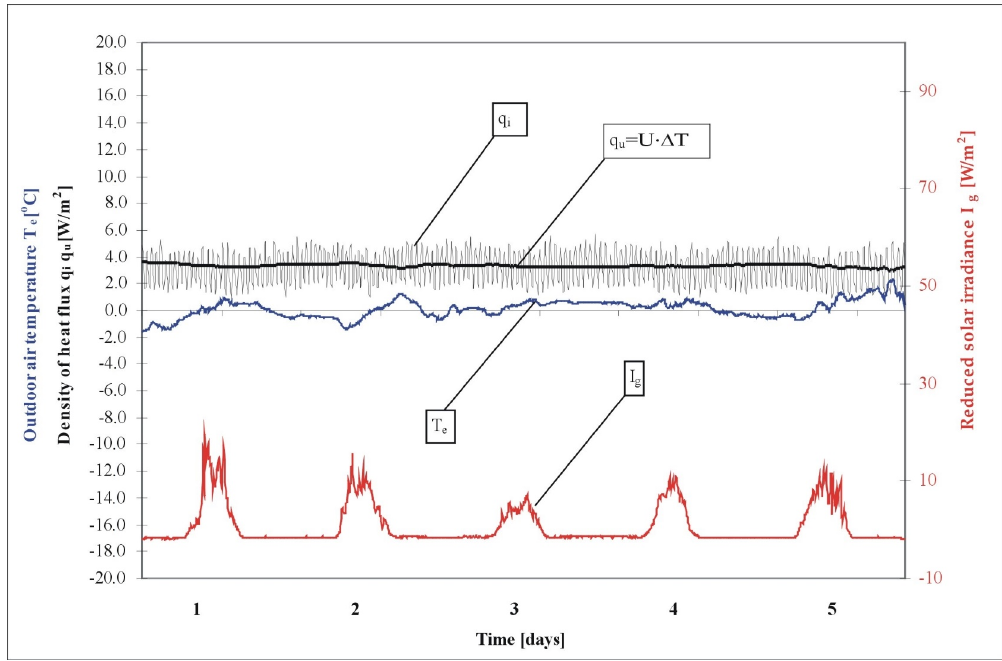
Figure 8. Distribution of outdoor air temperature ( Te ), heat flux density measured on the inner surface of the IGW and solar irradiance measured behind the outer glazing in the very low radiation period.